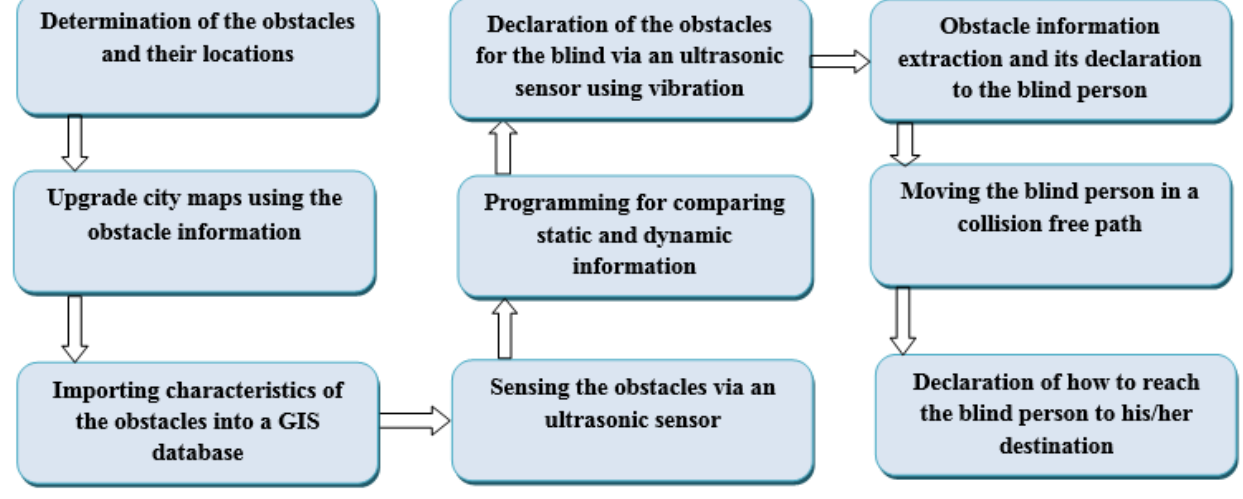
Figure 1. Research